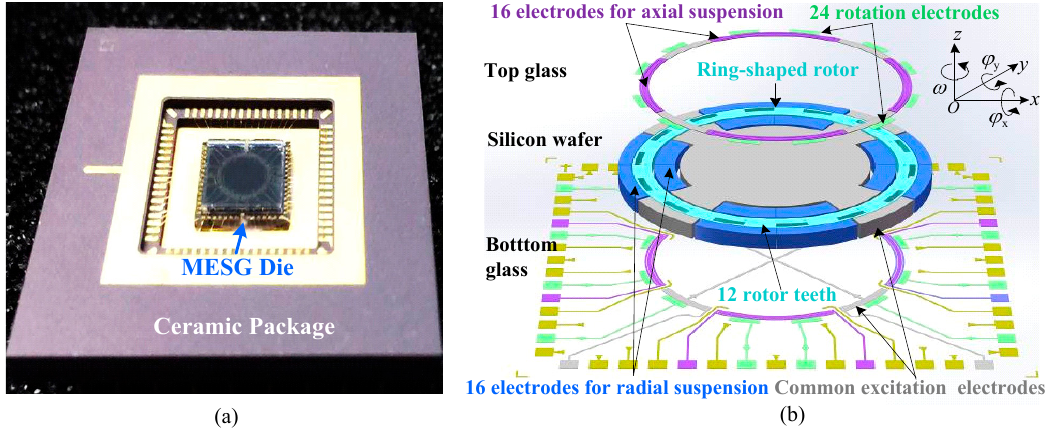
Figure 1. Micromachined electrostatically suspended gyroscope (MESG), ( a ) a ceramic packaged device and ( b ) the exploded view of rotor and electrode configuration.